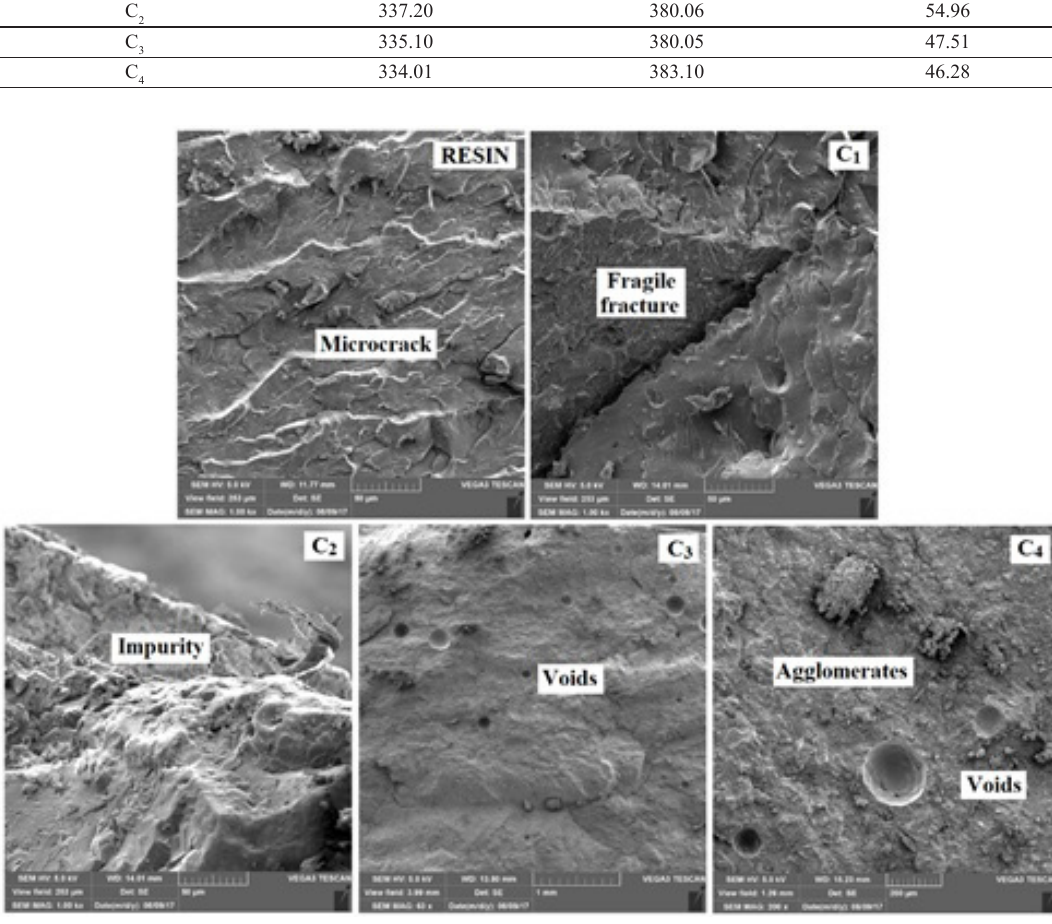
Figure 4. Table and bench manufactured with the C